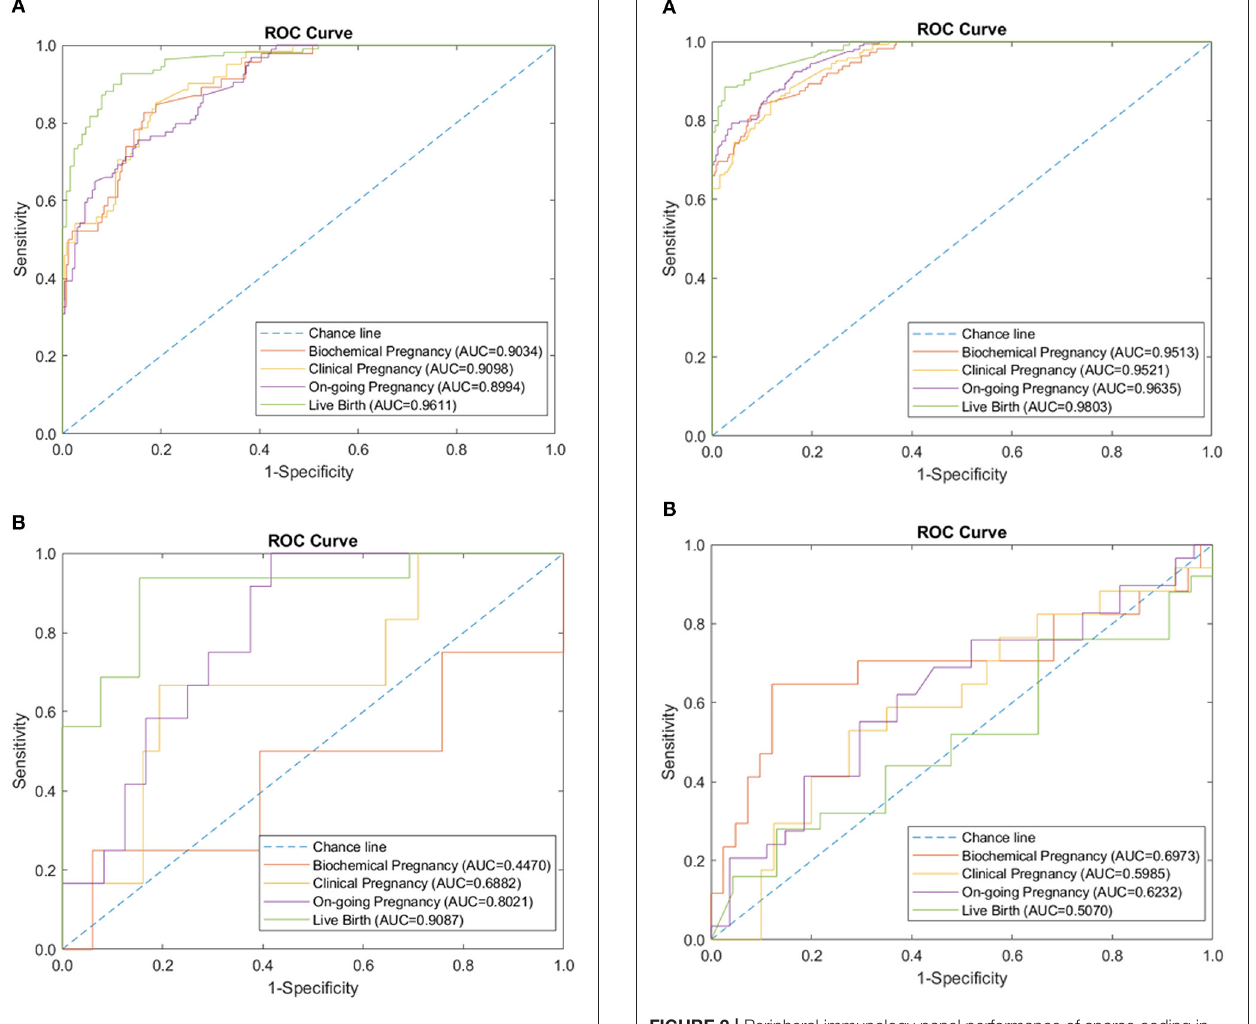
FIGURE 1 | Autoantibodies panel performance of sparse coding in predicting pregnancy outcomes at different pregnancy periods. (A) ROC plot of the training data set. (B) ROC plot of the testing data set.